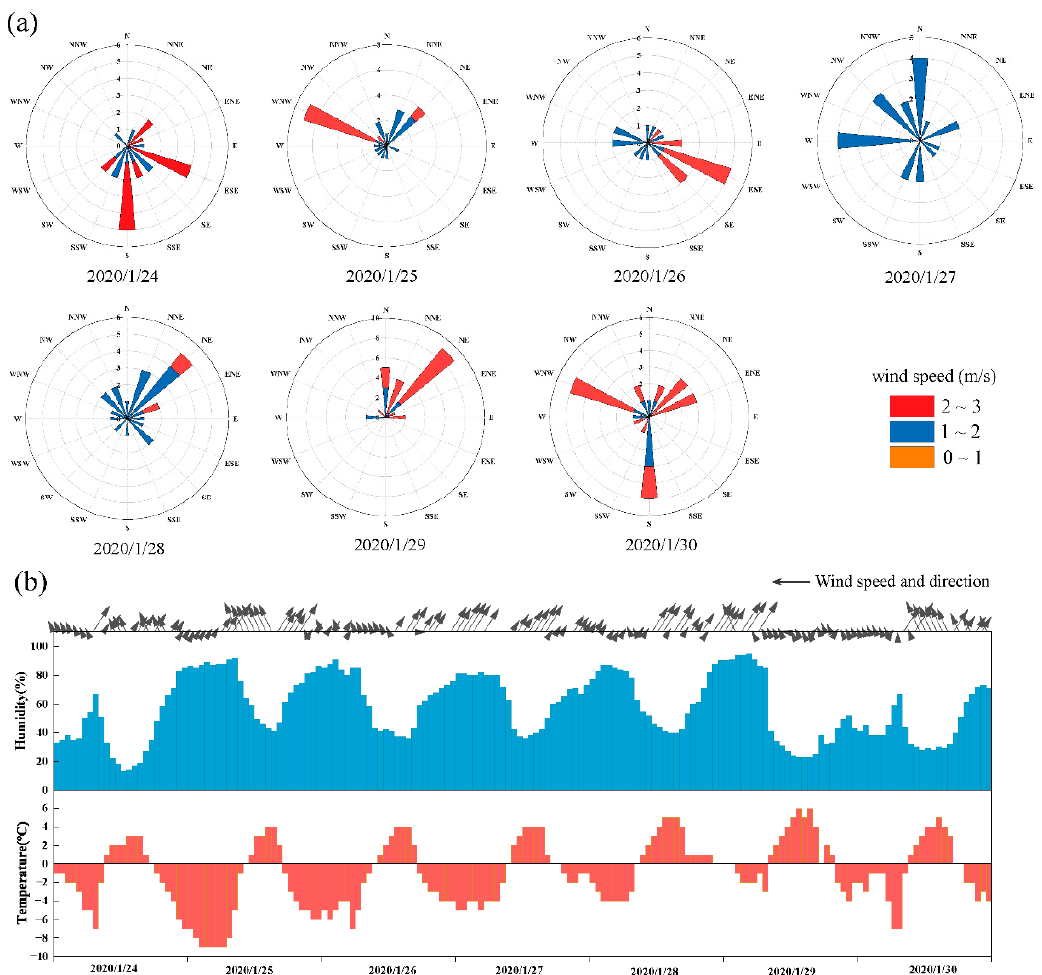
Figure 6. Daily and hourly changes in meteorological elements during the Spring Festival in 2020.